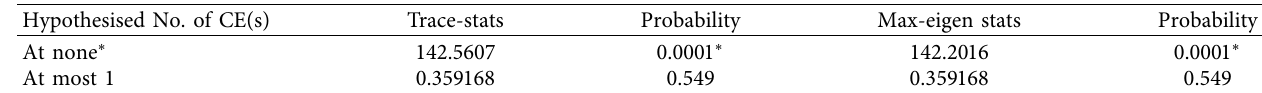
Table 5: The Johansen cointegration test.